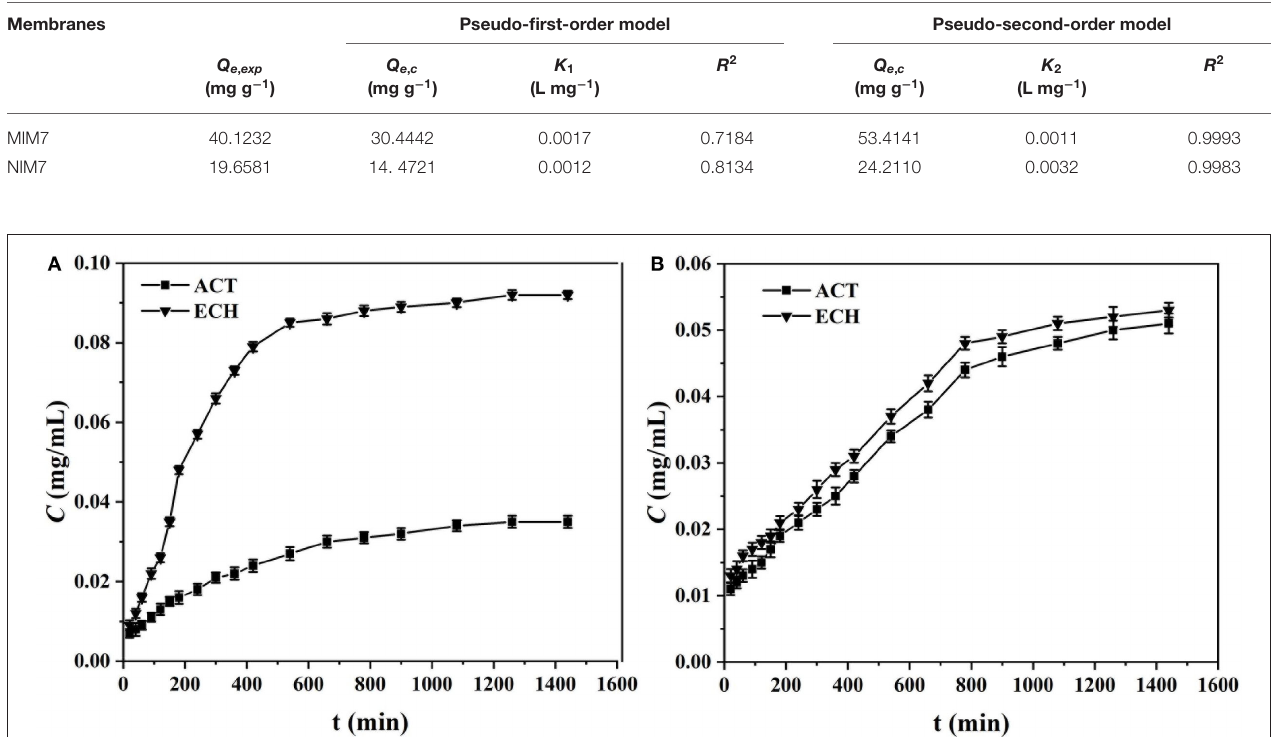
TABLE 3 | Kinetics constants for the pseudo-first-order and pseudo-second-order rate equations. Membranes